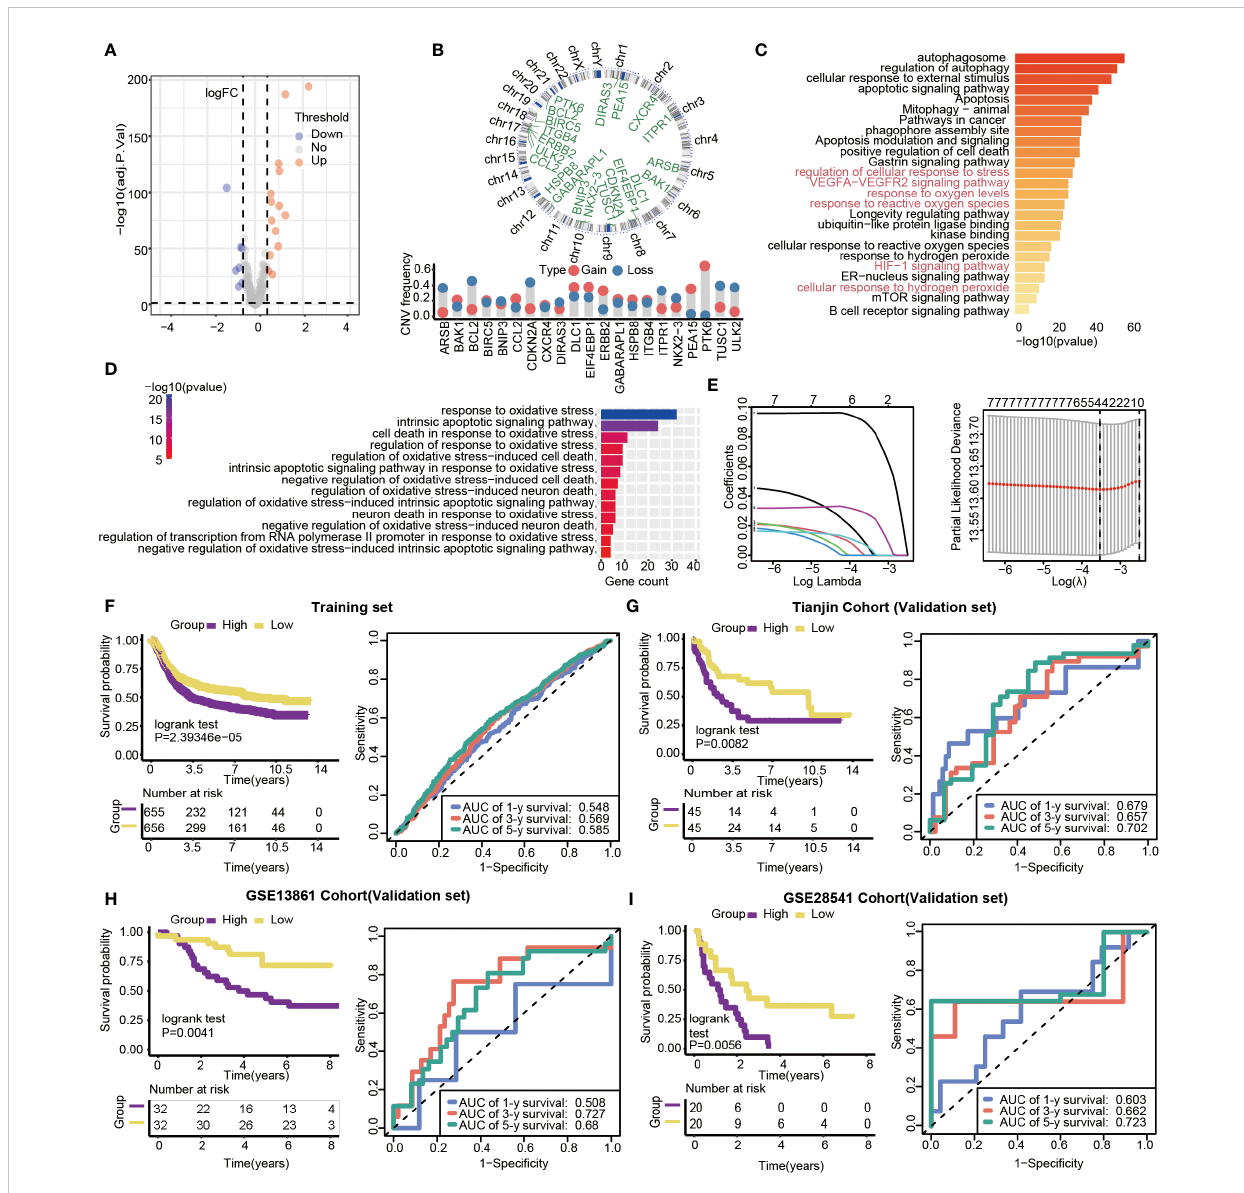
FIGURE 5 Gene features of DEGs and survival analysis based on the risk model in training and validation datasets. (A) Volcano plot of differential gene expression analysis. (B) Circular map of CNV regions in DEGs(top), and CNV frequency of 21 DEGs(bottom). (C) Genetic functional enrichment analysis, and the pathways related to oxidative stress are colored red. (D) GO enrichment analysis of oxidative stress-related pathways. (E) LASSO deviance pro fi les, and LASSO coef fi cient pro fi les. (F – I) Kaplan-Meier survival curves and 1-,3- and 5-year ROC curves for patients between high- and low-risk groups in the training set (n=1311, P<0.05), Tianjin validation set (n=90, P<0.05), GSE13861validation set (n=64, P=0.0041) and GSE28541 validation set (n=40,